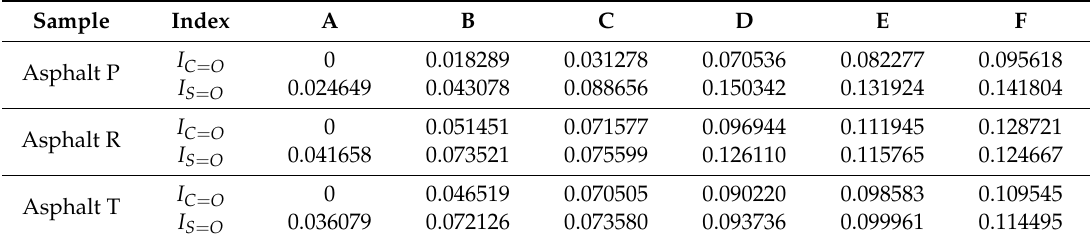
Table 9. Values of C=O and S=O